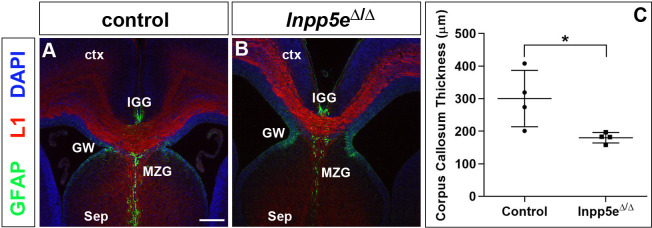
Formation of the corpus callosum in E18.5 Inpp5eΔ/Δ embryos.(A, B) Coronal section through the telencephalon stained with L1 and GFAP to reveal the corpus callosum (CC) and glial cells, respectively. The corpus callosum was smaller in Inpp5eΔ/Δ embryos while the glial wedge (GW), the induseum griseum glia (IGG) and the midline zipper glia (MZG) occupied their correct position surrounding the corpus callosum. (C) Quantification of corpus callosum thickness. Statistical data are presented as means ± 95% confidence intervals (CI); Mann-Whitney test; n = 4; *p<0.05. Scale bar: 250 μm.